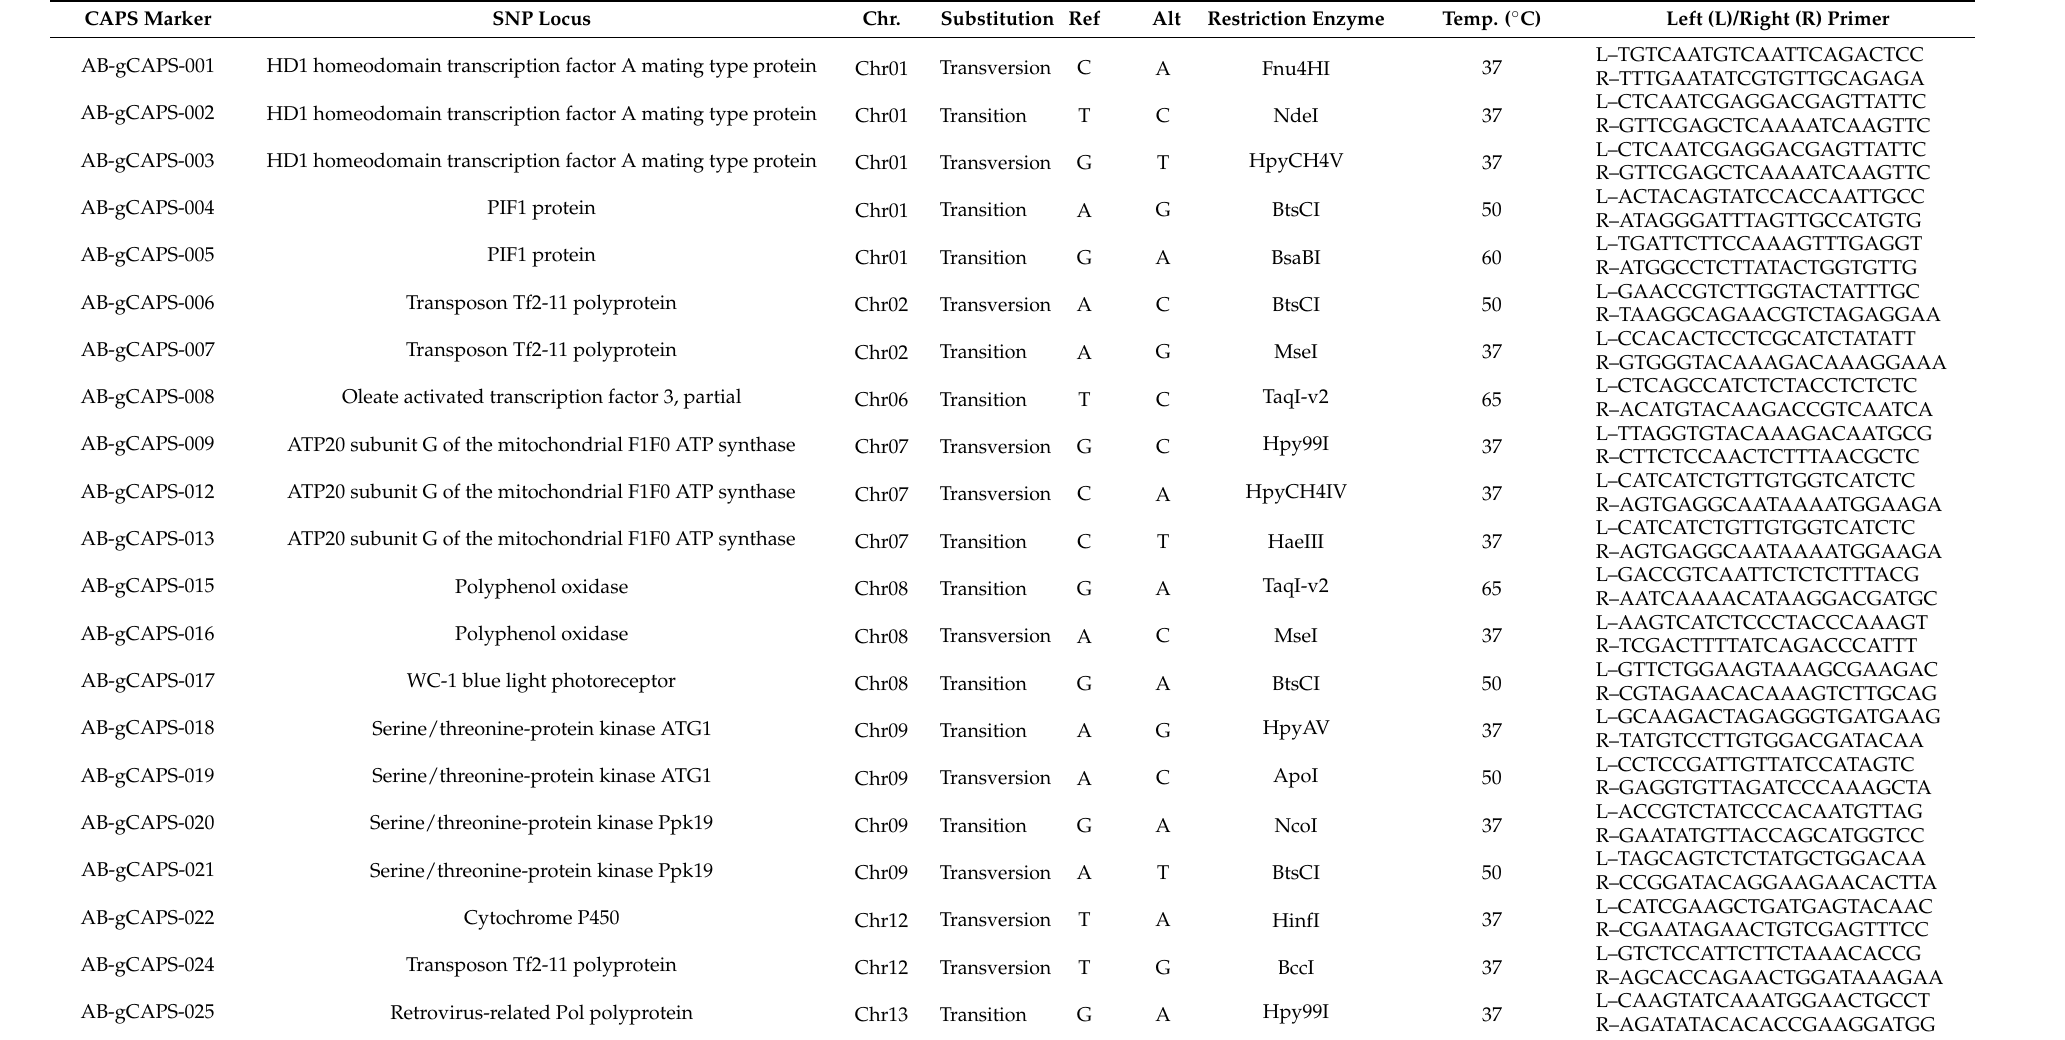
Table 2. CAPS markers developed using SNPs mined from A. bisporus resequencing